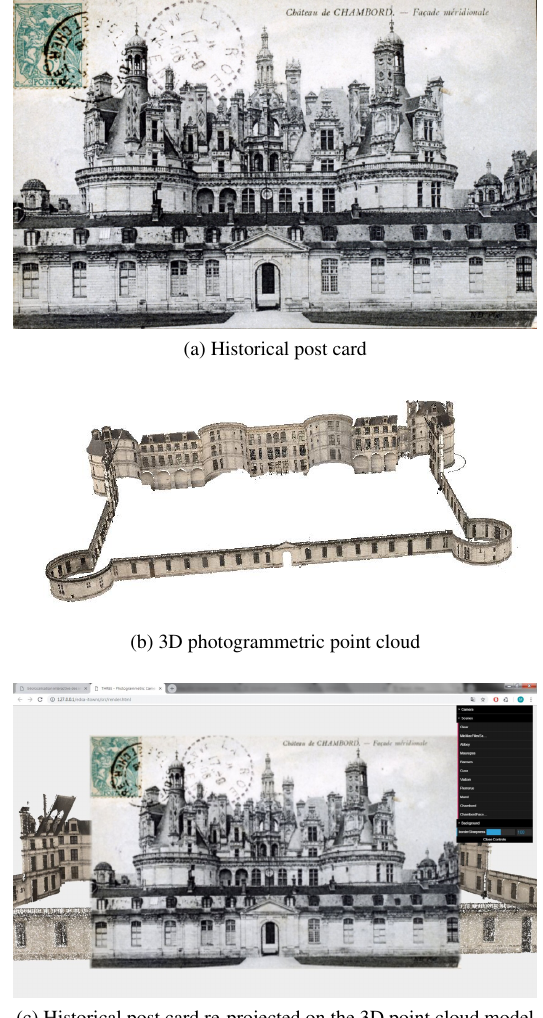
Figure 2. Results on the Chambord castle,